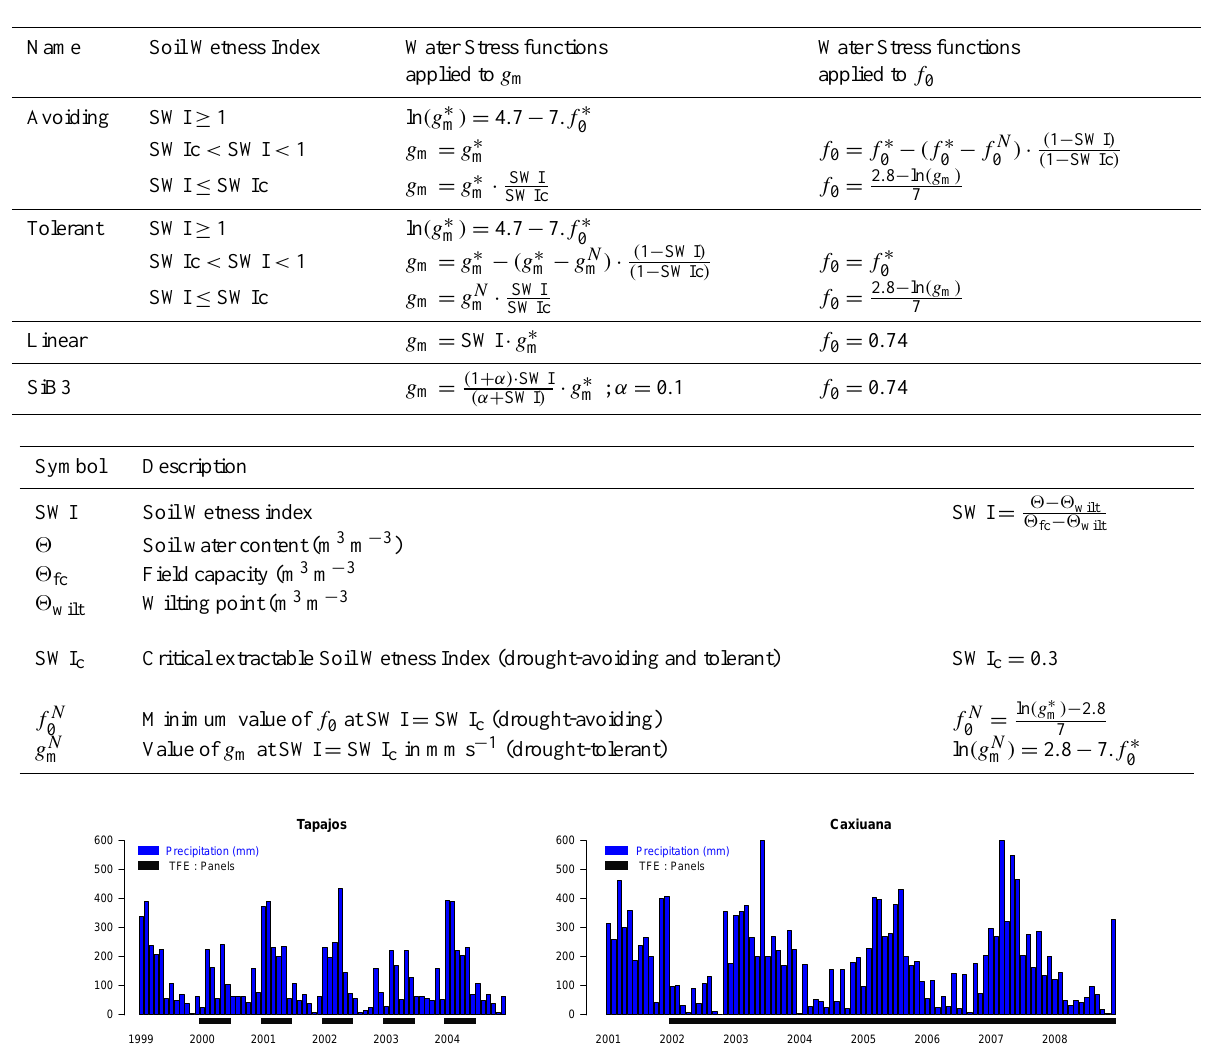
Table 3 – References and available period for observations used in this study. Table 2. Description of ISBA CC : water stress functions.